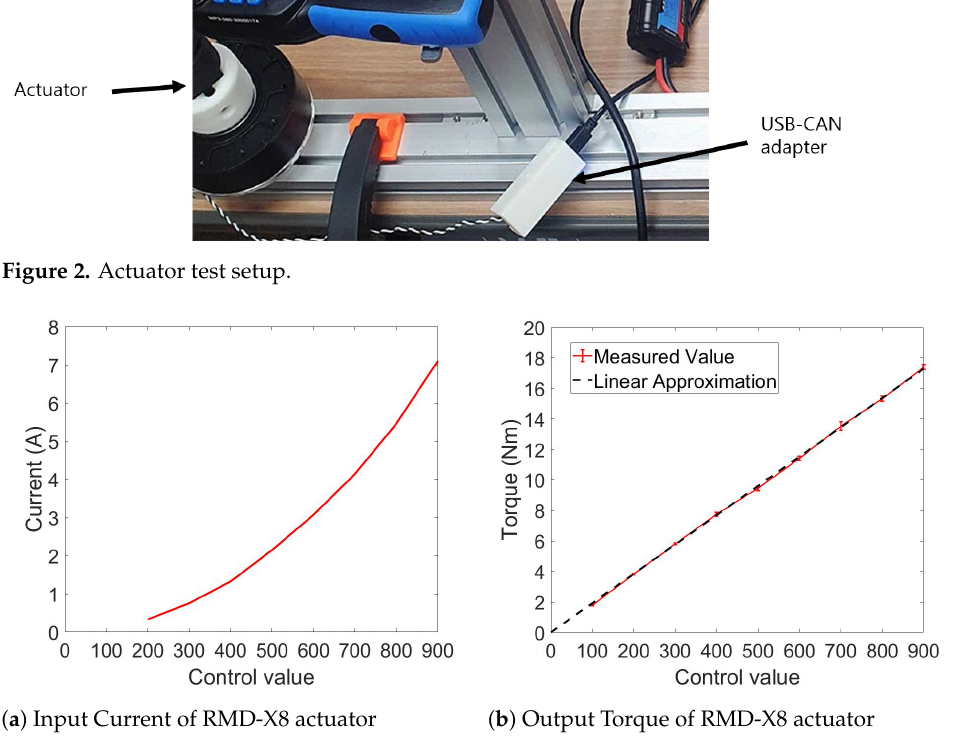
Figure 3. Input current and output torque over torque control value for RMD-X8 actuator.